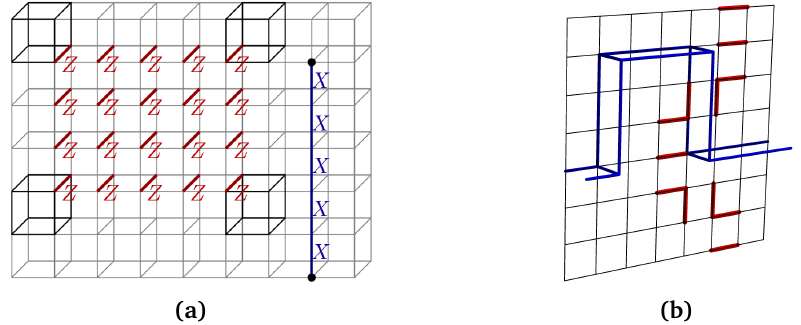
Figure 5: (a) Visualization of particle creation operators in the X-cube model. The red links correspond to a membrane geometry on the dual lattice. The product of Z operators over these edges excites the (darkened) cube operators at the corners. The product of X operators over the links comprising the straight open blue string creates excitations at its endpoints (black dots); (b) Motion of dipoles of vertex and cube excitations in a plane is achieved by applying X on the blue links and Z on the red links